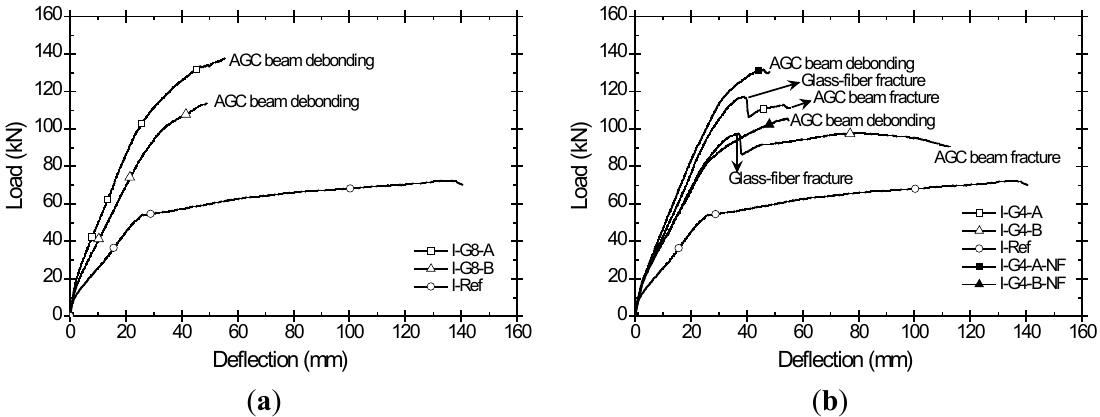
Figure 7. Load-deflection responses of slab specimens with ( a ) glass-fiber of W80-F20 and ( b ) glass-fiber of W40-F60.